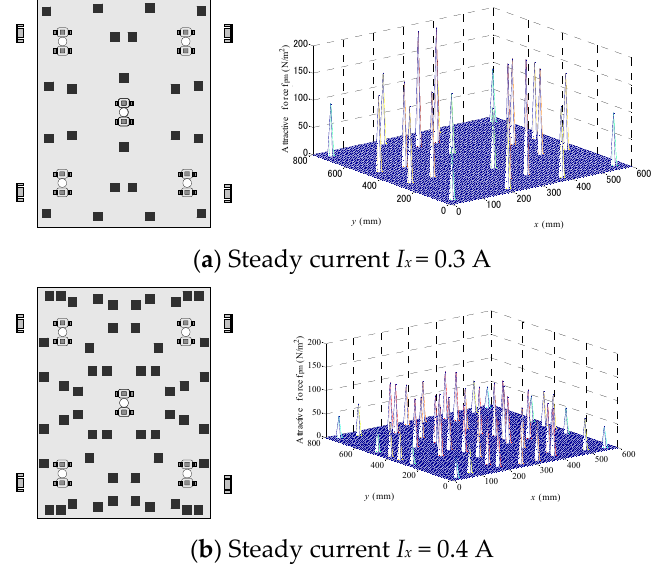
Figure 7. Optimal placement of permanent magnets considering the horizontal attractive force and distribution of the attractive force acting on the steel plate.